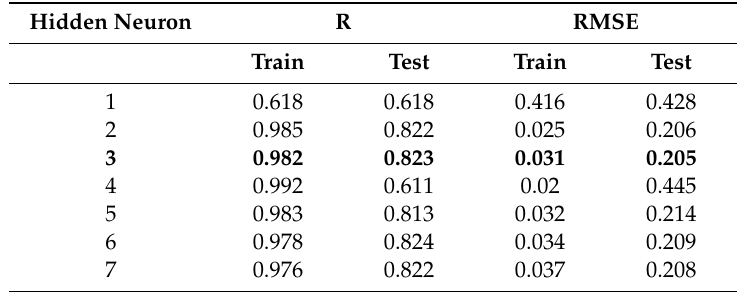
Table 2. Results from tuning back propagation neural network (BPNN) structure.